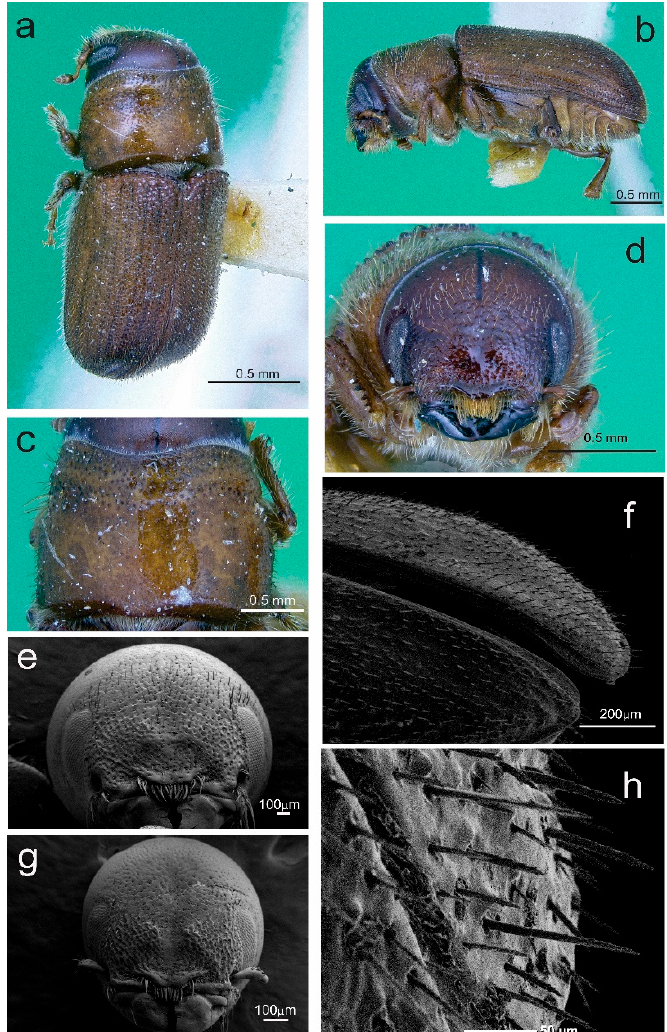
Figure 7. Dendroctonus brevicomis : ( a ) Female in dorsal view, ( b ) female in lateral view, ( c ) female pronotum, ( d ) frons sculpture of female, ( e ) female frons, ( f ) elytral declivity, ( g ) male frons, ( h ) elytra in dorsal-lateral view. Photos a – d (only existing paratype of D. brevicomis ). Gallery. Parental tunnels subtransversely-winding (Figure 8f) [12]. Larval galleries short, narrow, and on both sides of parental gallery.